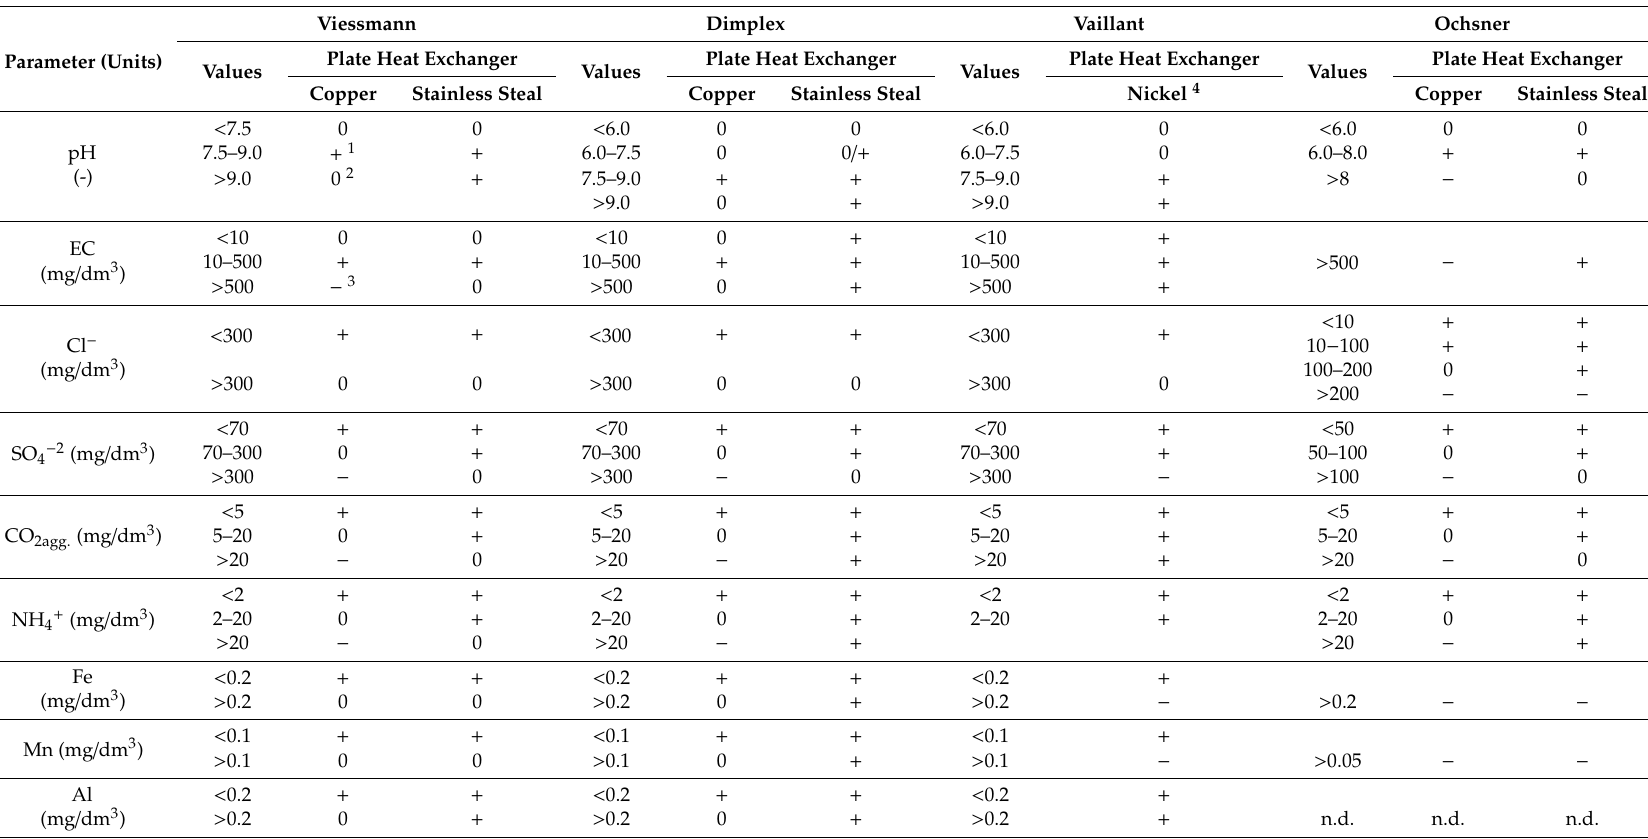
Table 2. Characteristics of physicochemical parameters in accordance with the guidelines of heat pump manufacturers (on the basis of